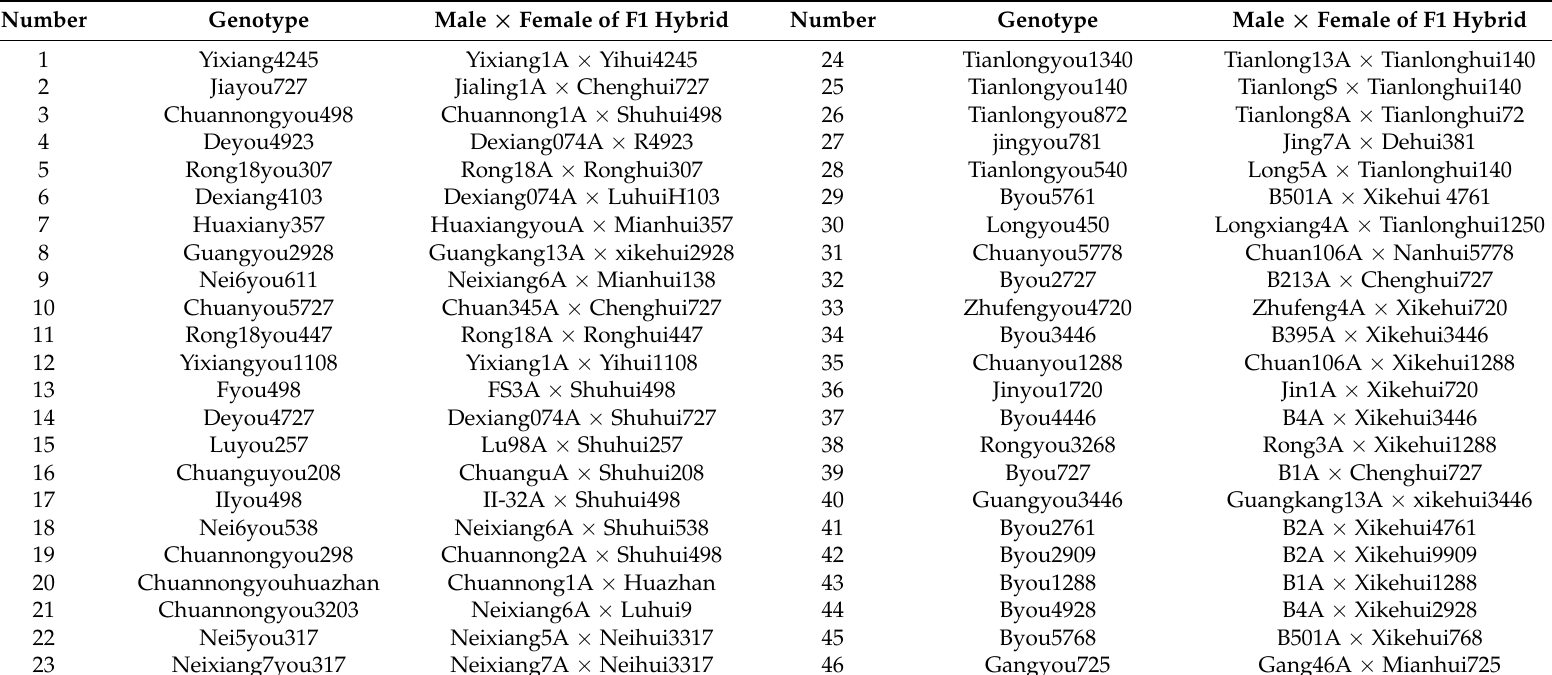
Table 1. Information on the 46 rice varieties collected in Sichuan Province, China for drought